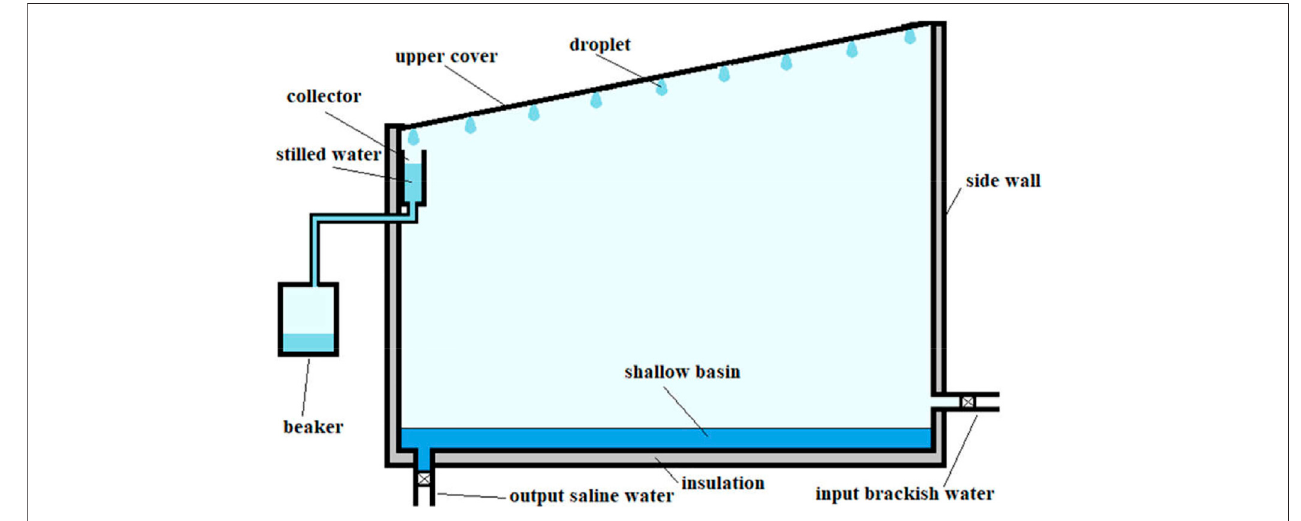
FIGURE 1 | Schematic of a simple solar